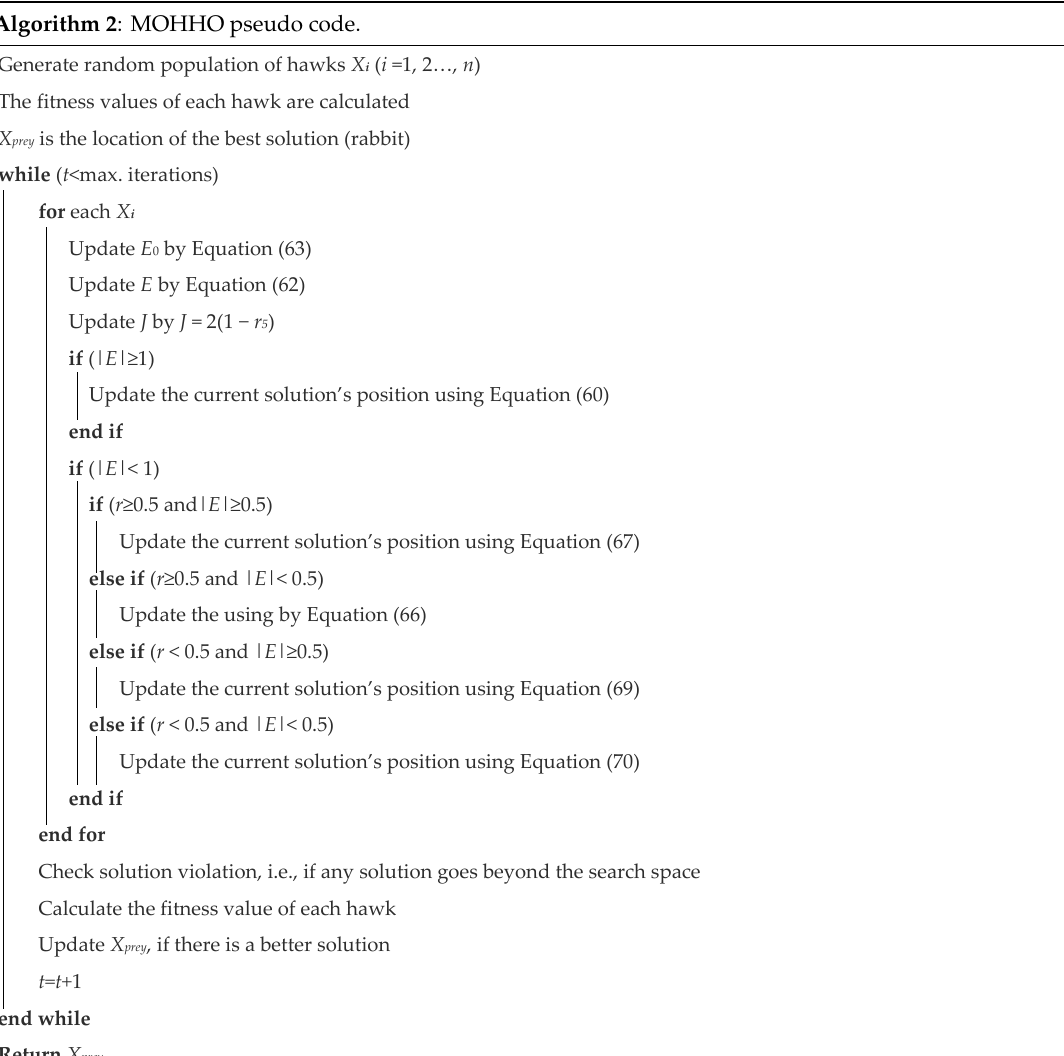
Algorithm 2 : MOHHO pseudo code.